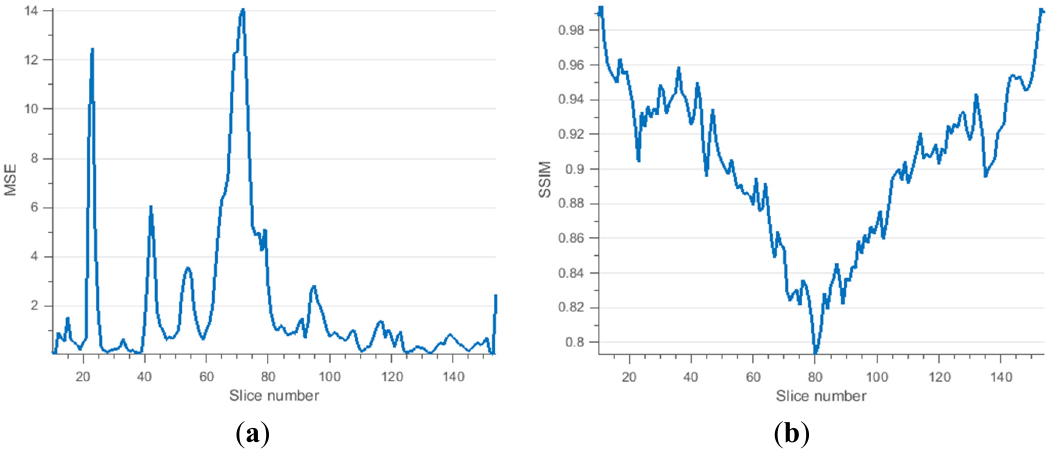
Figure 9. MS lesion cluster counts from discrete (solid) and fuzzy (dashes) estimations compared to ground truths slice by slice in the brain ROI of the brain data with mild MS lesions.